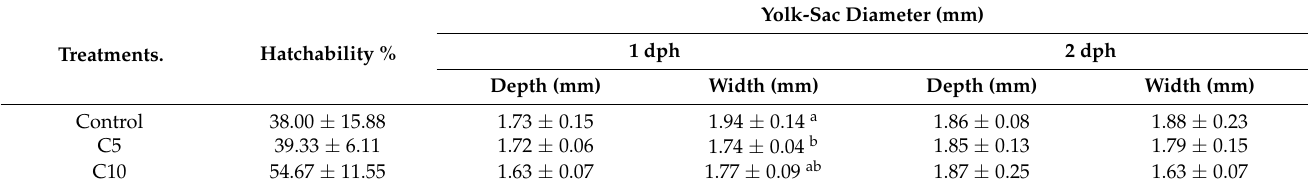
Figure 1. Morphological development of red tilapia (Scale bar 1 mm). ( a ) Egg; ( b ) 0 dph; ( c ) 1st dph; ( d ) 2nd dph; ( e ) 6th dph (malformation appeared in C10 group); ( f–h ) 30 dph red tilapia fry of the control, C5, and C10 groups, respectively. Table 1. Hatchability rate (%) and yolk-sac diameter (mm) (depth and width) of red tilapia larvae exposed to CoQ10 (0, 5, and 10 mg/L), during the first and second day post hatch